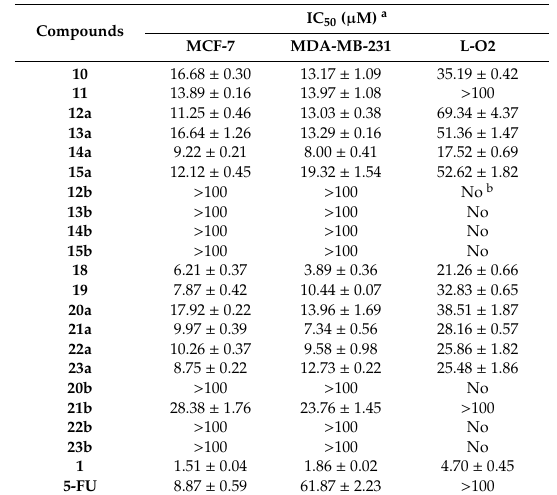
Table 1. Evaluation of target compounds against di ff erent cell